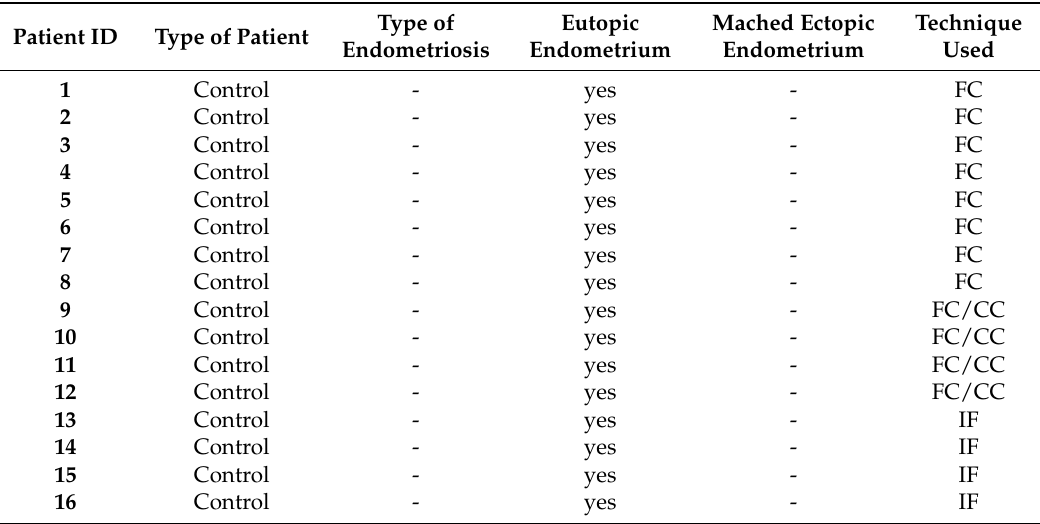
Table 1. Patients used in the